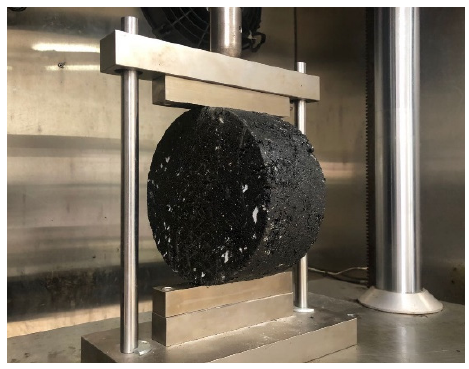
Figure 3. IDEAL cracking test (IDEAL-CT).